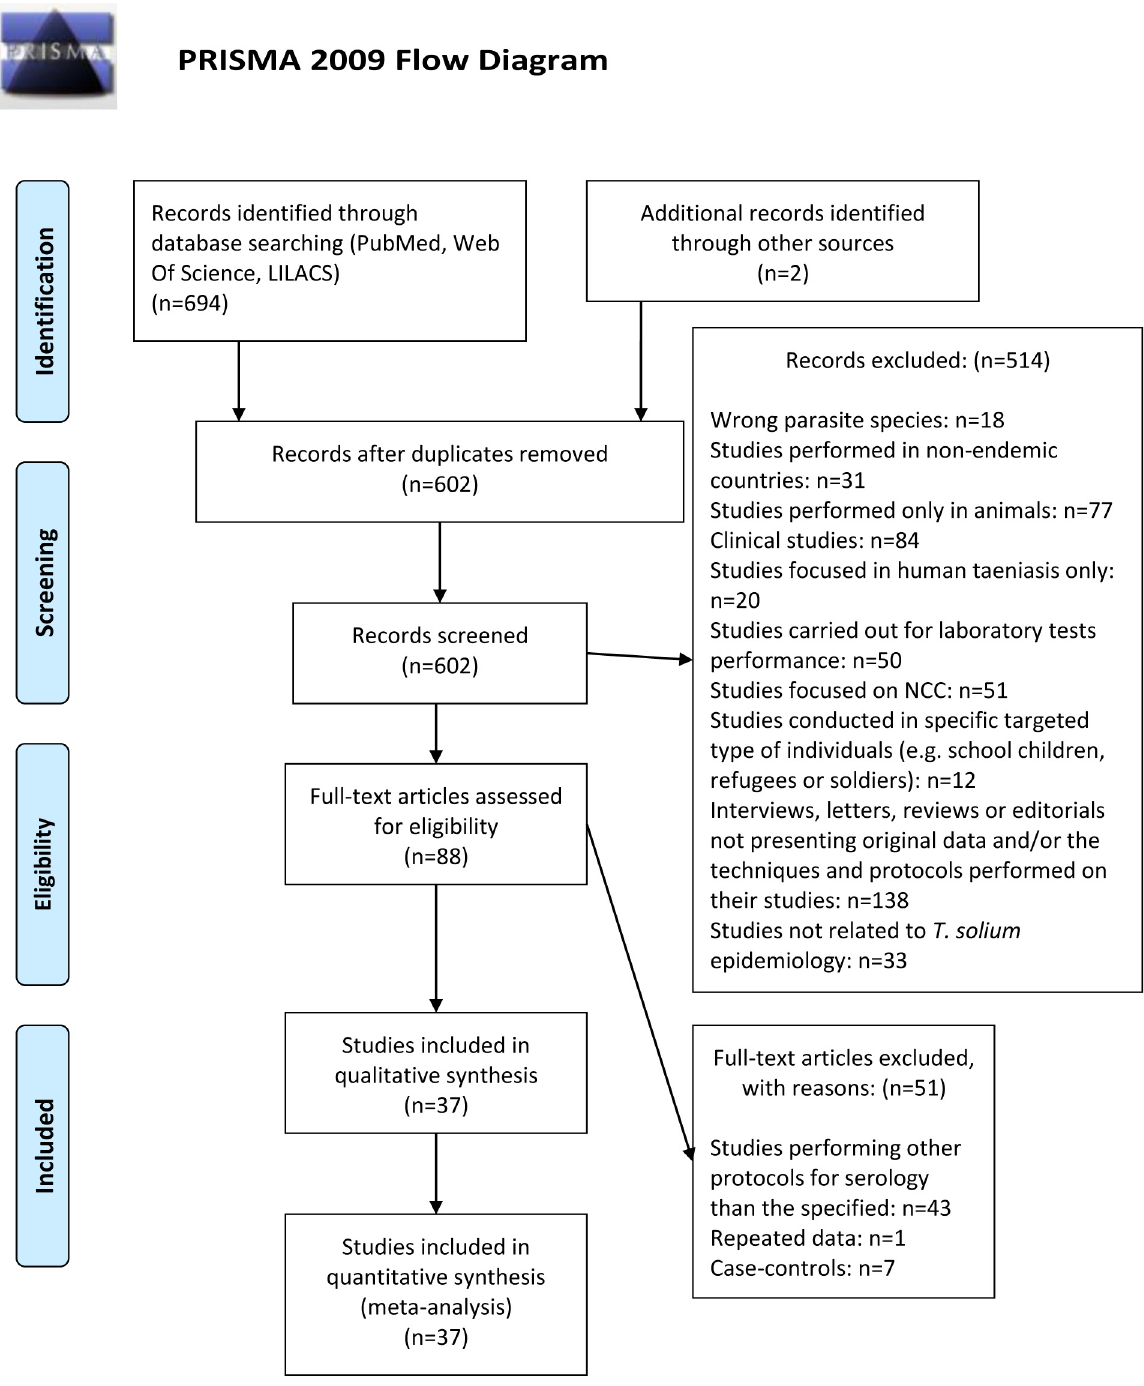
Fig 1. Flow diagram describing literature search and selection of studies (PRISMA 2009 flow